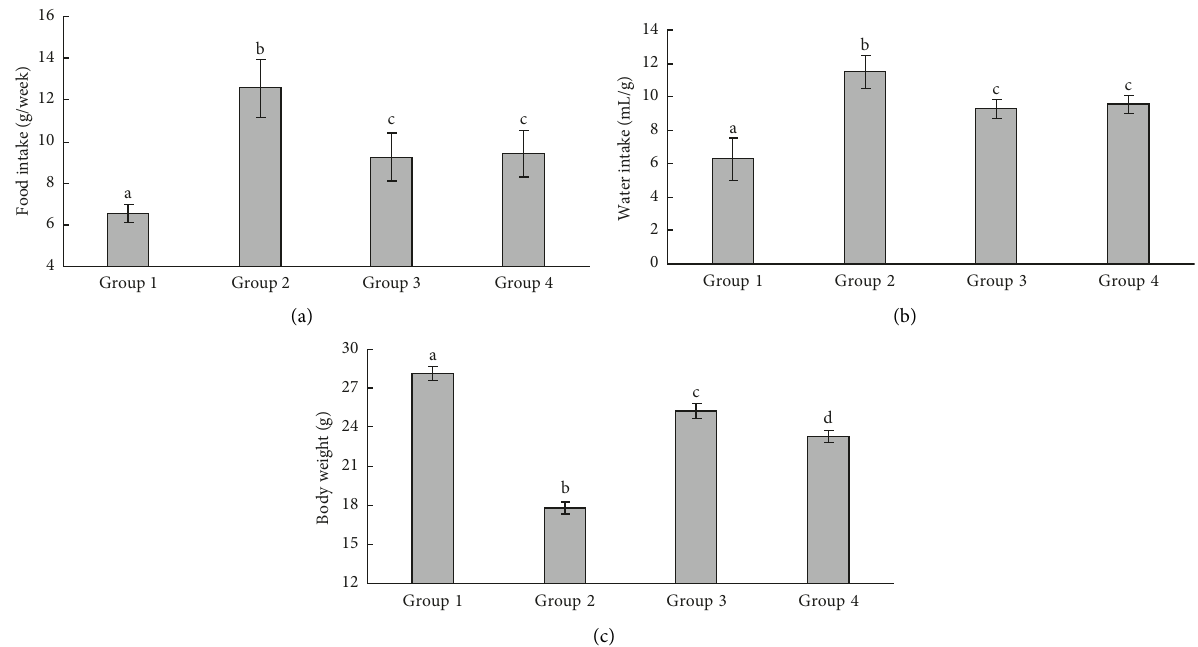
Figure 1: Effect of SDF on food intake, water intake, and body weight in nondiabetic and diabetic mouses. Data are expressed as mean ± standard deviation (SD). Values with different letters are significantly different, p ≤ 0 . 05. Group 1: nondiabetic group; Group 2: diabetes model group; Group 3: metformin group; Group 4: SDF group.